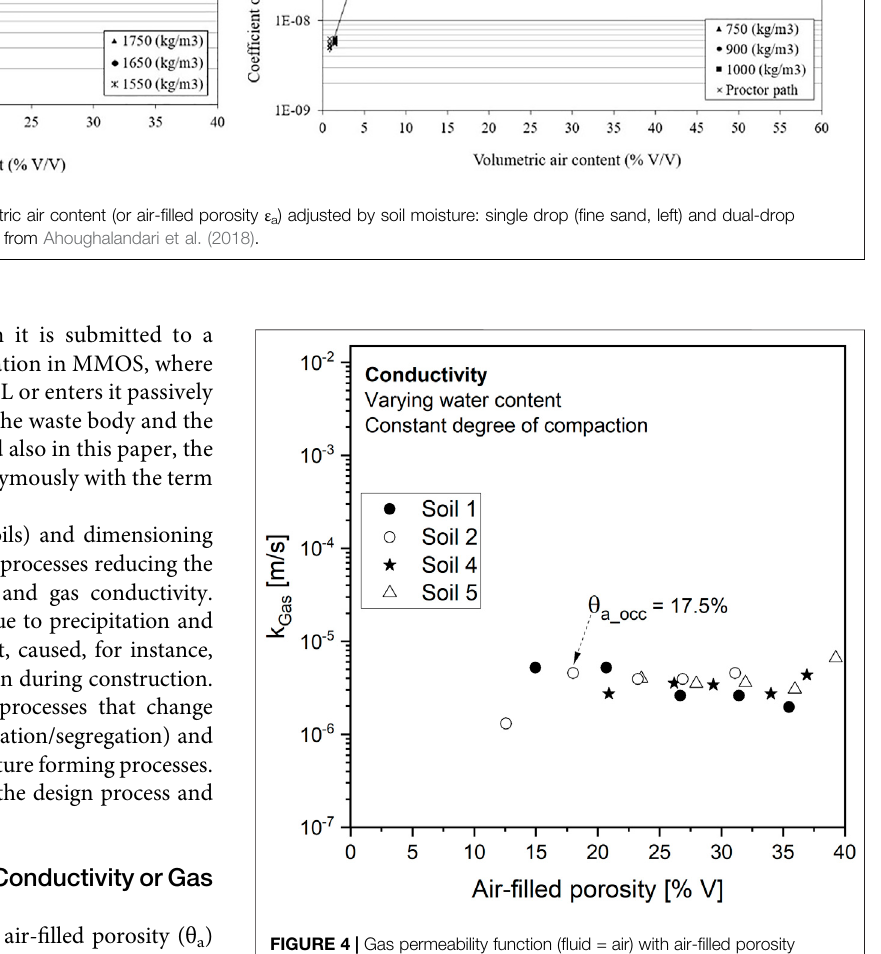
FIGURE 4 | Gas permeability function ( fl uid = air) with air- fi lled porosity ( ε a ) adjusted by soil moisture in different sandy candidate MOL soils. Adapted from Gebert et al. (2019). θ a_occ not reached for soils 1, 4 and